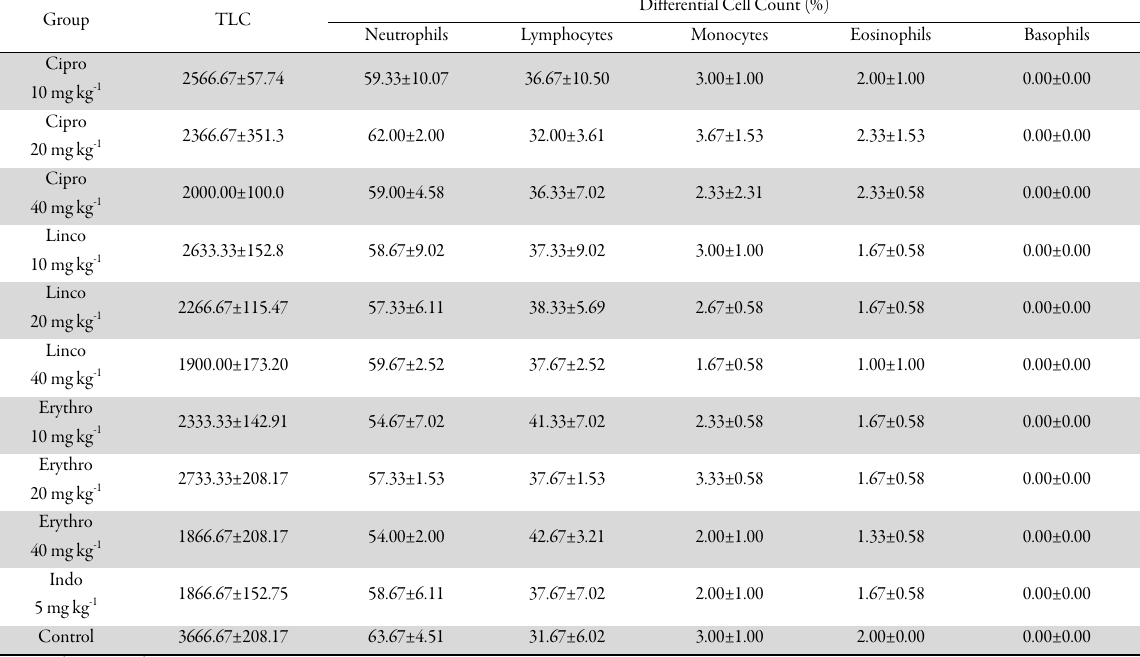
Table 4. Effect of the various antibiotics on agar-induced leukocyte mobilization Group